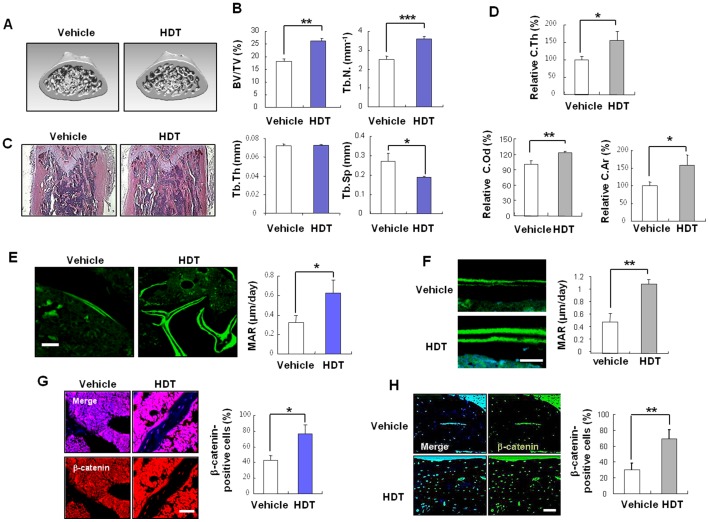
HDT extract enhances bone mass in normal mice.(A–H) HDT extract (200 mg/kg) was i.p. injected into 8-weeks-old male mice (n = 5) and the femurs were analyzed. (A) The representative μCT images are shown. (B) Trabecular bone parameters, such as BV/TV (%), Tb.N. (mm−1), Tb. Th (mm) and Tb.Sp (mm) from the μCT analysis are presented. (C) Photomicrographs of H&E stained-femur from vehicle- and HDT extract-treated mice are shown (original magnification: ×40). (D) Cortical bone parameters such as C.Th, C.Od, and C.Ar were measured from μCT 3D images and were normalized by the values of vehicle, respectively. (E–F) Calcein double staining (left) and mineral appositional rate (MAR; right) of trabecular bone (E) and endocortical surface (F) at femurs (n = 3). Scale bars, 20 µm. (G–H) Florescence staining of β-catenin (left) in the femoral trabecular (G) and cortical bones (H) and quantification data are shown (n = 3; right). Scale bars, 50 µm. (B, and D–H) *p<0.05, **p<0.01, ***p<0.001 versus vehicle.